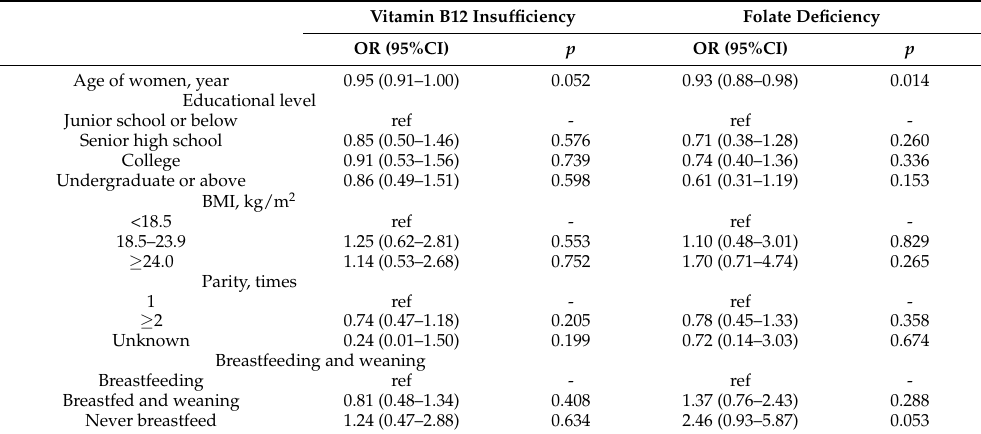
Table A1. The adjusted association of the relevant variables with vitamin B12 insufficiency and folate deficiency by multiple logistic regression model.